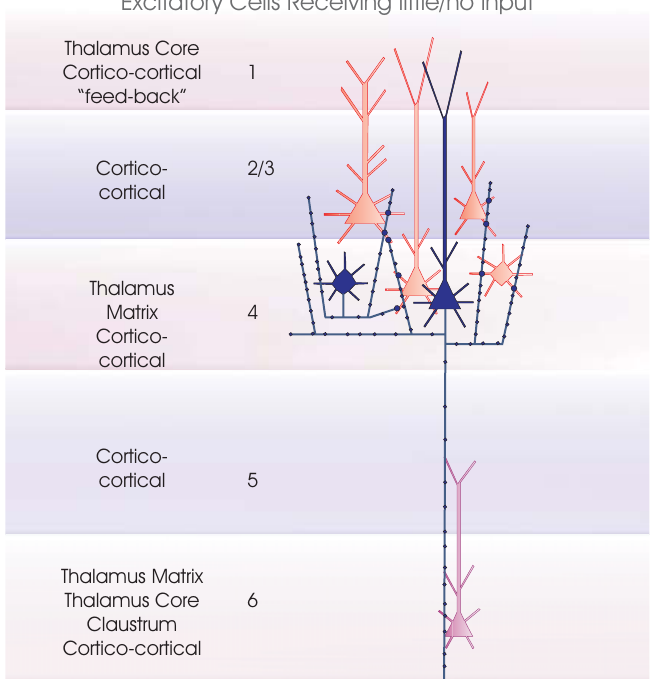
Figure 3. Layer 4 spiny excitatory cells . The two major subclasses of layer 4 spiny excitatory cells, pyramidal cells and spiny stellates are summarized in this cartoon (blue). The major inputs to each layer are indicated to the left. Spiny, excitatory postsynaptic targets that have been demonstrated with paired intracellular recordings are shown in red, the purple cell indicates a connection that has been demonstrated, but for which there are too few examples to identify target cell class(es) fully. Where a class of spiny excitatory cell is not indicated in a particular layer, it has not been tested sufficiently often with layer 4 spiny cells in paired recordings to determine whether the connection